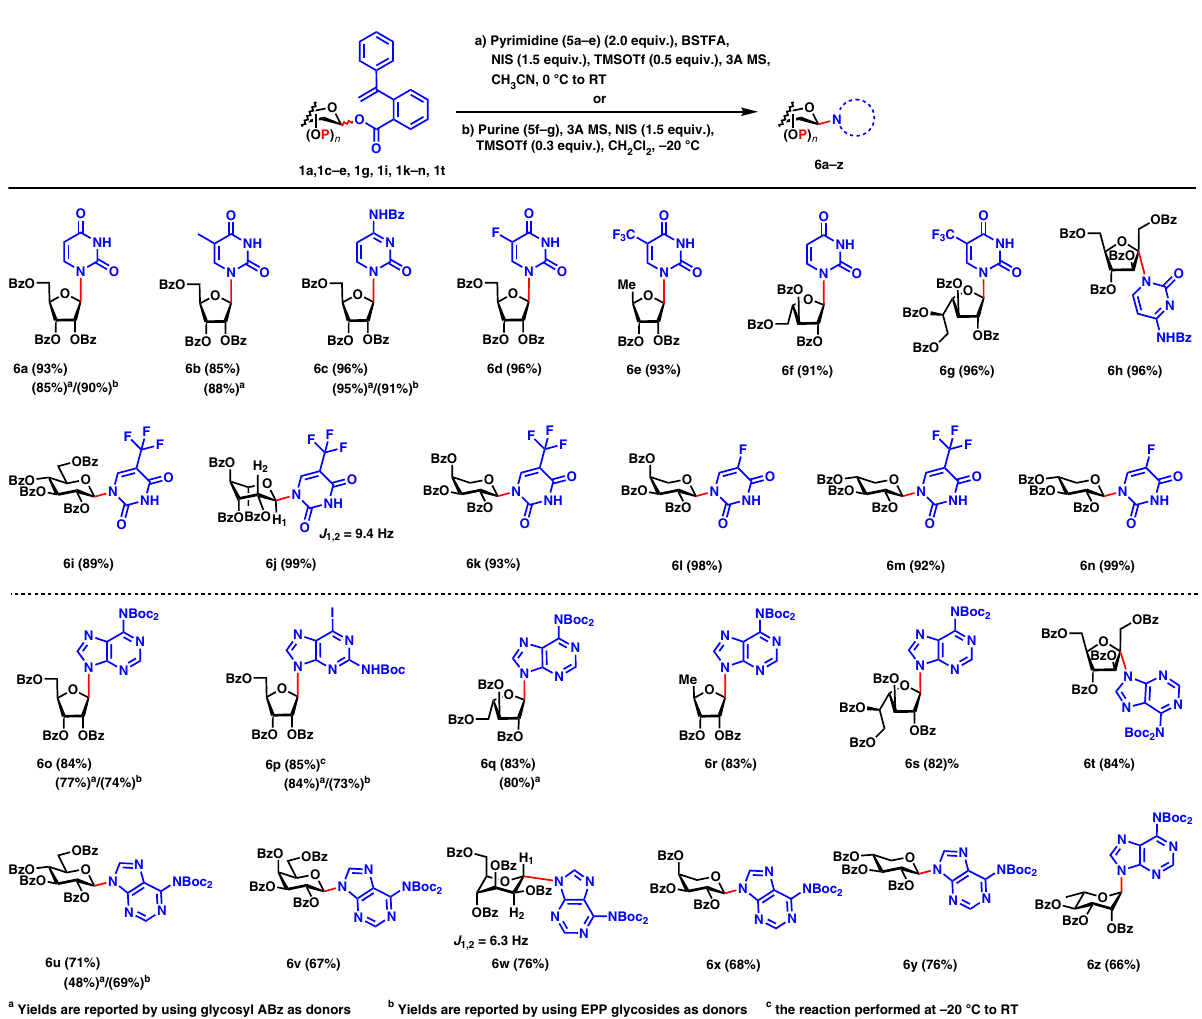
Fig. 3 Scope of synthesis of nucleosides with glycosyl PVB donors. Highlighted in blue are leaving groups and nucleophilic acceptors and in red are glycosidic bonds cleaved and formed. Boc t